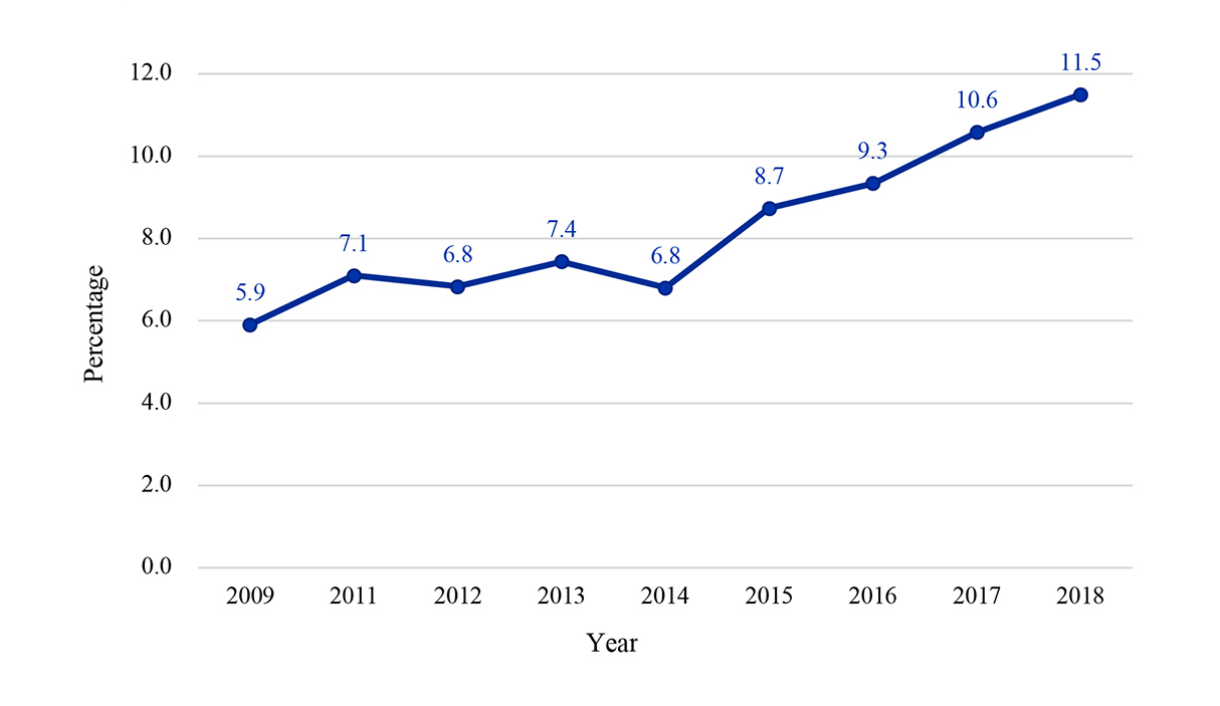
Figure 1. Trends in web-based prescription-filling behavior among US adults from 2009 to 2018. The prevalence of online prescription fill among adults in the US was found to significantly increase from 2009 (N=13,319,877) to 2018 (N=28,308,262; P <.01). The National Health Interview Survey did not release the data related to online prescription fill in the 2010